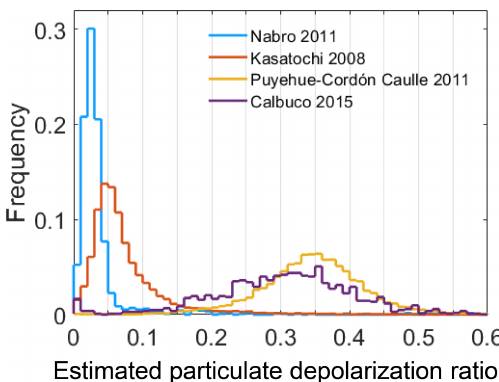
Figure 16. Estimated particulate depolarization ratio for all unique stratospheric aerosol layers detected in the first 2 weeks following the first CALIOP observation of the volcanic plume. PSA and layers with | CAD score | < 20 are excluded.